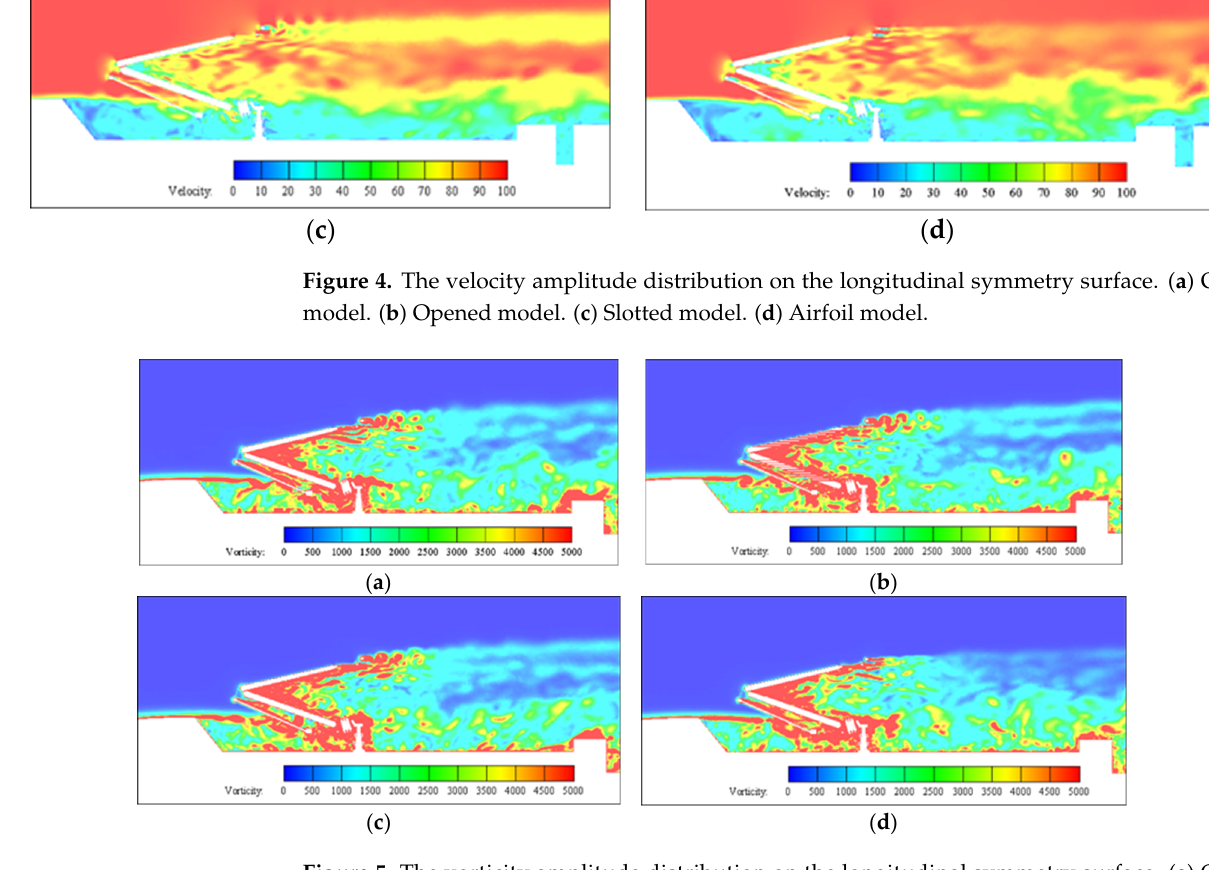
( d ) Figure 6. Q-value distribution on the longitudinal symmetry surface. ( a ) Original model. ( b ) Opened model. ( c ) Slotted model. ( d ) Airfoil model. According to the original model in Figures 4–6, it can be seen that the middle and upper regions of the pantograph have typical flow field structural characteristics: the middle of the